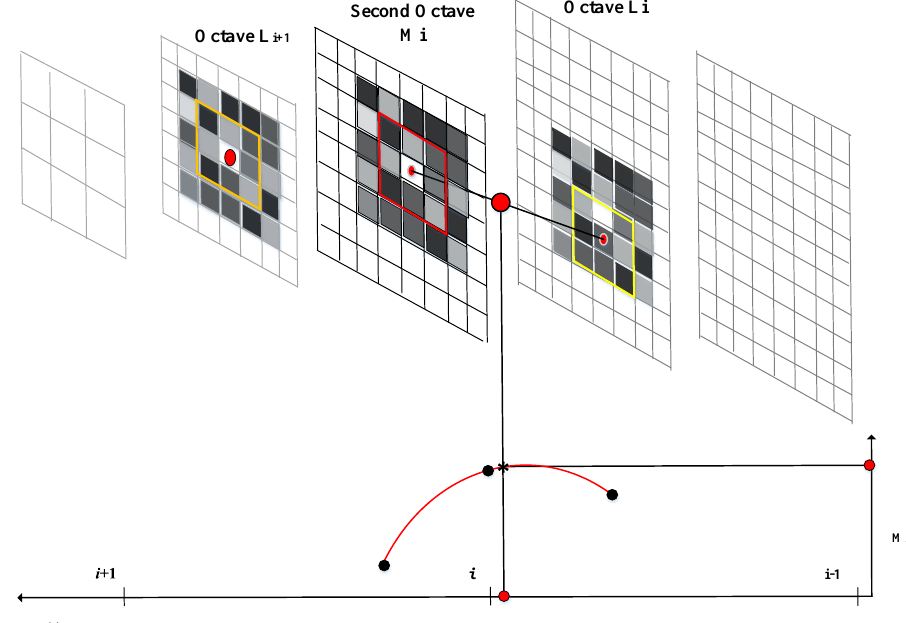
Figure 6. Maximum and minimum values determination of the candidate feature.